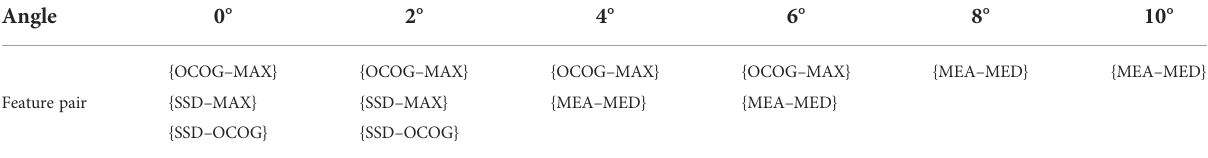
TABLE 2 The feature pairs of which the MIMs are larger than 0.65 at six small incidence angles. Angle